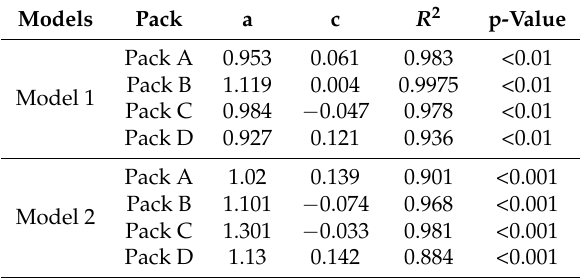
Table 4. Parameters and significance of the linear regression models for the four battery packs under Model 1 and Model